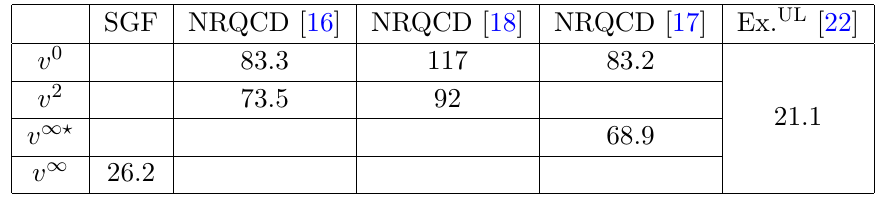
Table 1 . The cross section (cid:27) e + e (cid:0) ! (cid:17) c + (cid:13) calculated in SGF and NRQCD at LO in (cid:11) s , as well as the experimental upper limit measured by the Belle Collaboration (in unit of